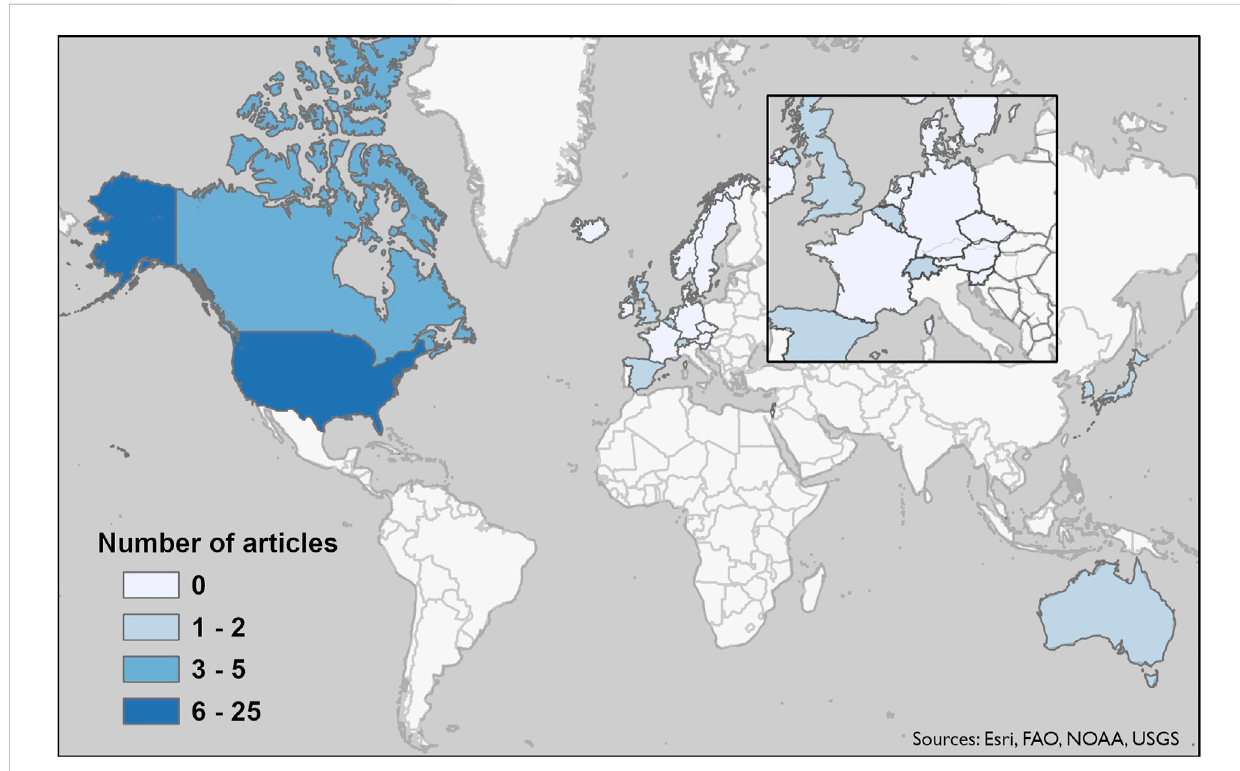
FIGURE 2 Numberofarticlesfromeachcountrythatwereincludedintheliteraturereview.OnlycountrieswithaHumanDevelopmentIndex(UNDP,2020)of 0.9 or above were